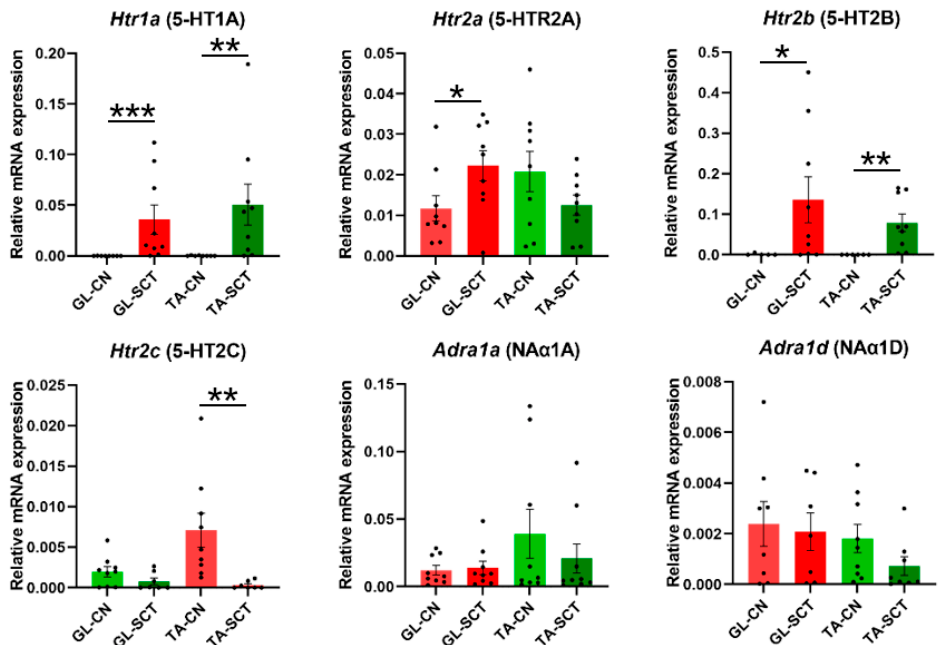
Figure 6. SCT upregulates the transcript level of 5-HT 1A and 2B receptors similarly in GL and TA MNs. Increased transcript level of Htr1a (5-HT1A), Htr2a (5-HT2A), and Htr2b (5-HTR2B) subunits of 5-HT receptors in GL and TA MNs is accompanied by a decrease in Htr2c (5-HT2C) subunit in TA MNs but not GL MNs. SCT does not alter gene expression of NA receptor subunits. Data are means +/ − SEM. Mann-Whitney U -test, * p < 0.05; ** p < 0.01; *** p < 0.001.